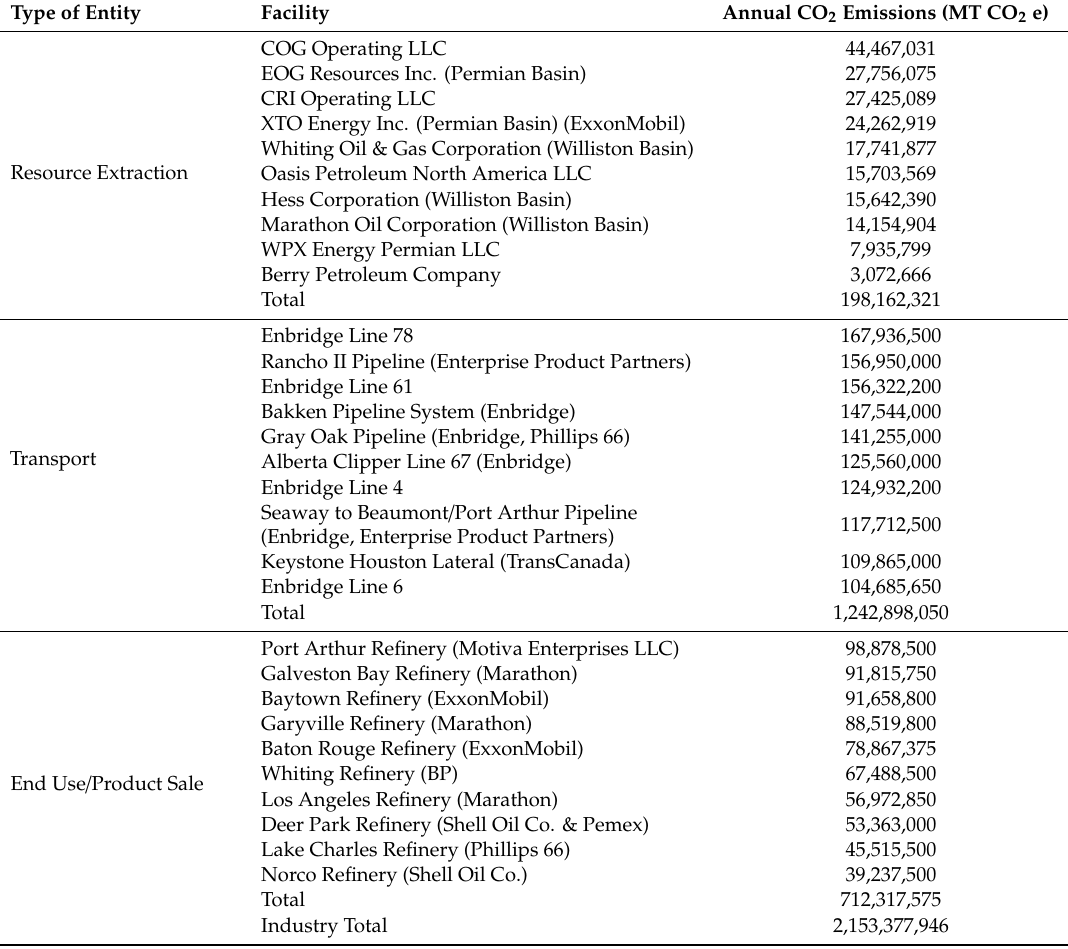
Table A6. Top CO 2 Bottlenecks of the Oil Industry for Resource Extraction, Transport, and End-use.